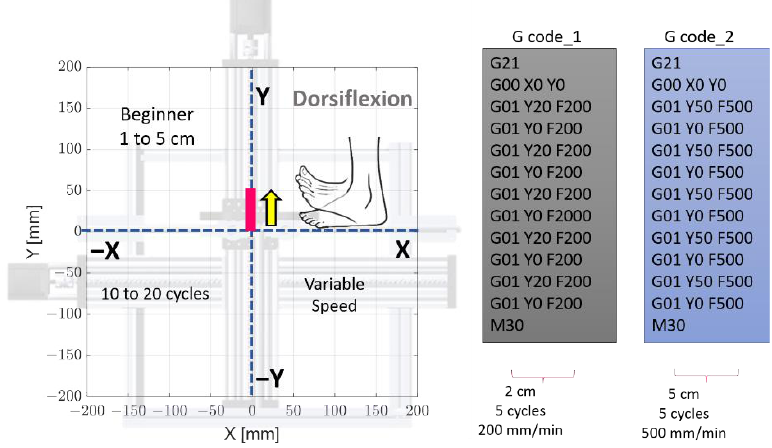
Figure 16. Beginner level for dorsiflexion rehabilitation.